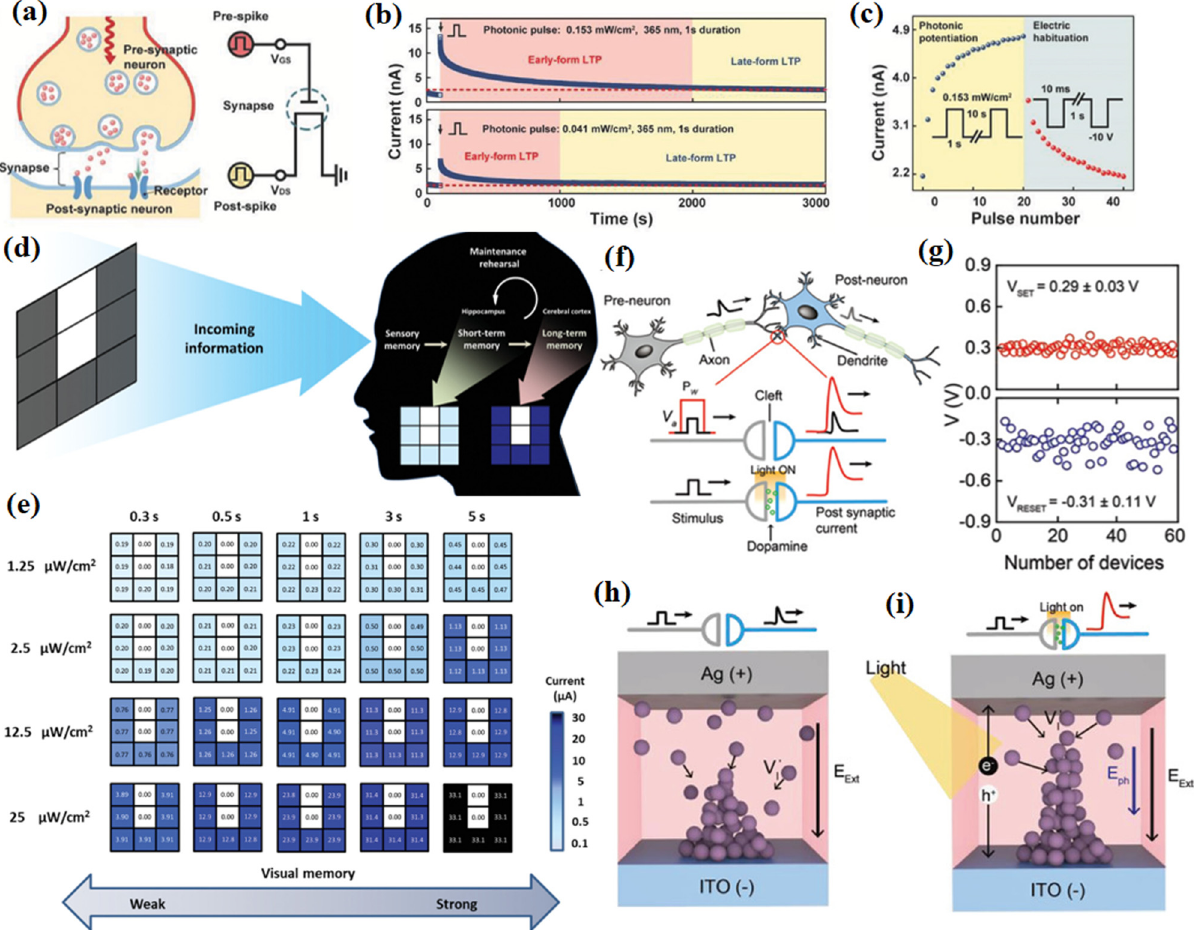
Figure 15: ( a ) Schematic diagram of synapse structure and arti fi cial synaptic device. ( b ) Presynaptic application of 365 nm photon pulses